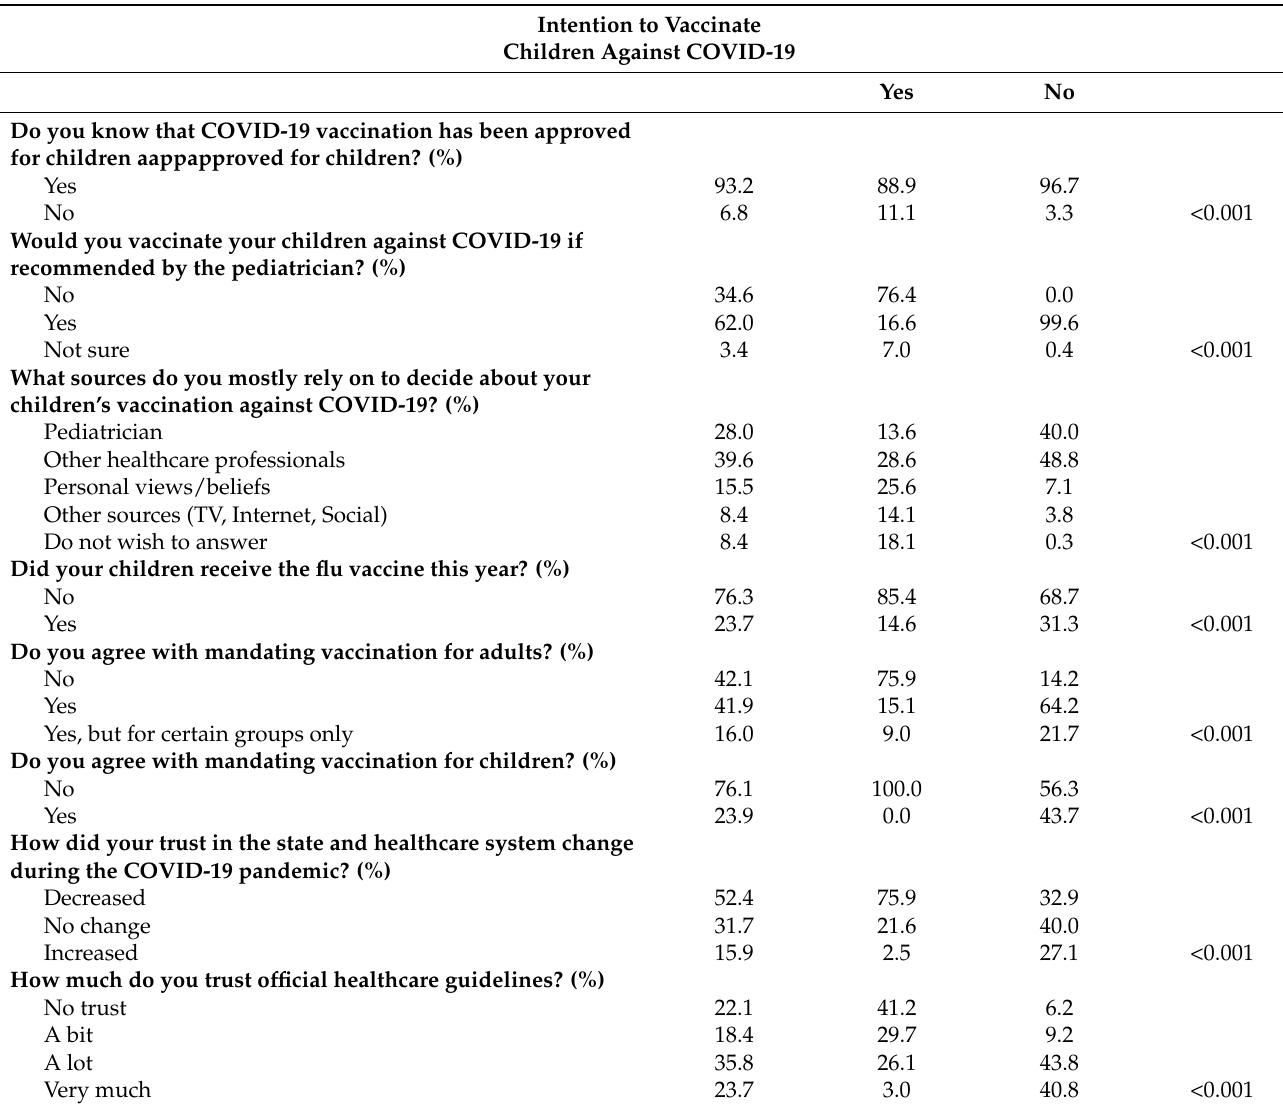
Table 2. Knowledge and attitudes of parents on COVID-19 vaccination overall and stratified by their intention to vaccinate their